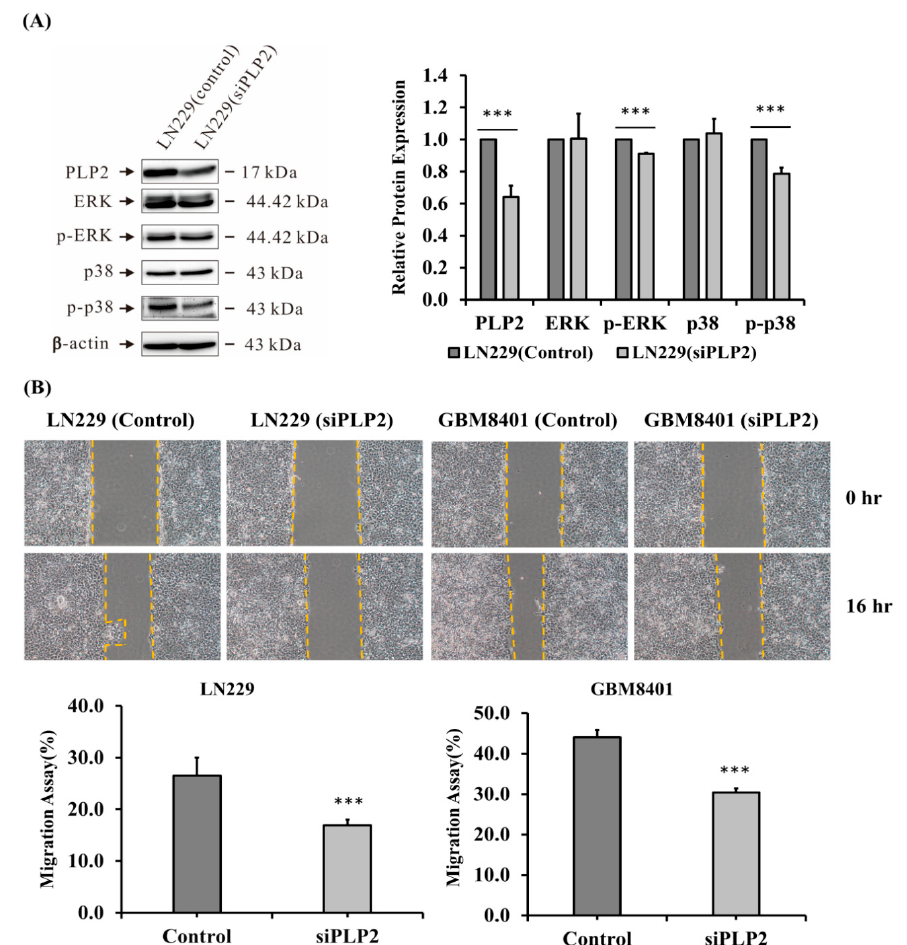
Figure 6. ( A ) Influence of the possible signaling pathway in the LN229 glioma cell line after siPLP2 and siRNA-A (NC)transfection. p-p38 and p-ERK showed a significant decrease after knockdown PLP2 expression. (*** p < 0.001); ( B ) Assessment of tumor migration ability in GBM8401 and LN229 glioma cell lines after siPLP2 and NC transfection. Glioma cells with a PLP2 knockdown revealed slow tumor migration after 16 h. (*** p < 0.001).